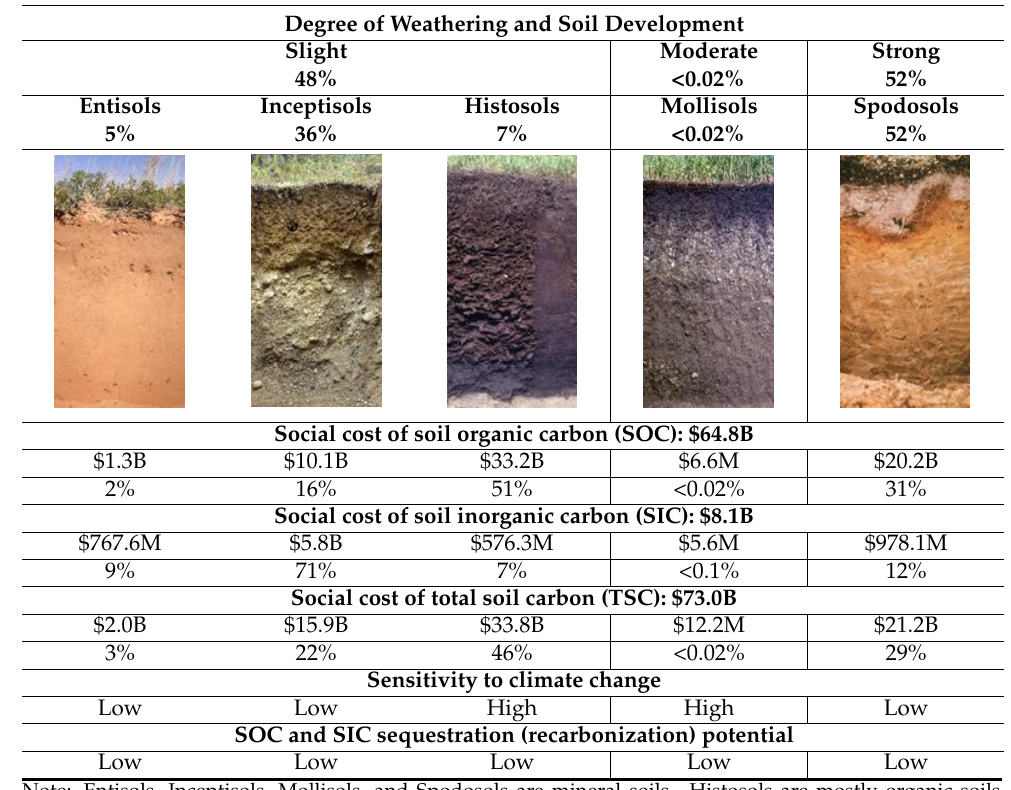
Table 12. Distribution of soil carbon regulating ecosystem services in the State of New Hampshire (USA) by soil order (photos courtesy of USDA/NRCS [24]). Values are taken/derived from Table 3, Table 6, Table 8, and Table 10. Soil Regulating Ecosystem Services in the State of New Hampshire